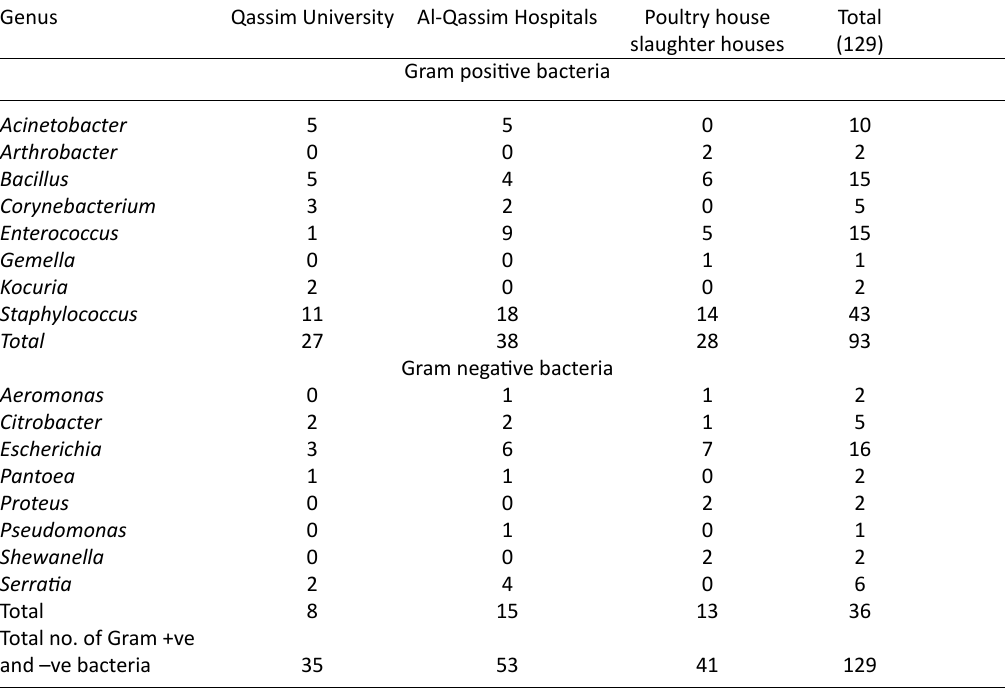
table 4. Incidence of airborne bacteria isolated from examining air samples of different localities Genus Qassim University Al-Qassim Hospitals Poultry house